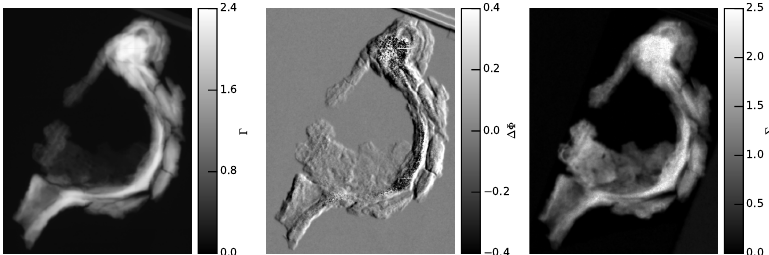
Figure 6. Attenuation ( left ), differential phase ( middle ) and dark-field image ( right ) of the iron fibula from Figure 4, taken at 80kVp and 22.5mAs per phase-step.